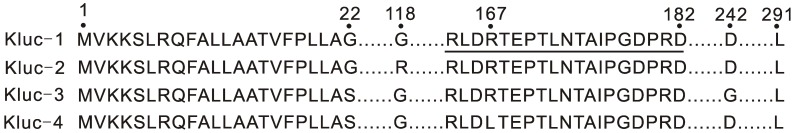
Amino acid sequence alignment of Kluc-3 and Kluc-4 with Kluc-1 from K. cryocrescens (GenBank accession No. AAK08976) and Kluc-2 from E. Cloacae (GenBank accession No. ABM73648).Dashes represent identical amino acid residues. The amino acids comprising the omega loop are underlined.